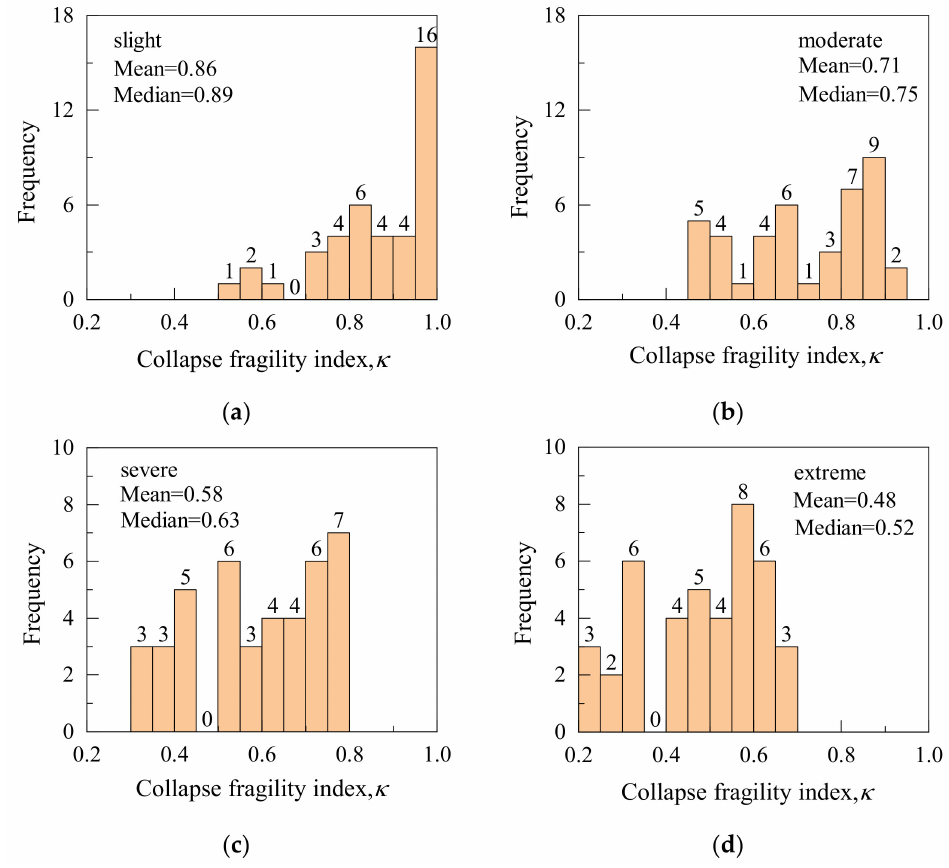
Figure 9. Frequency distribution of collapse fragility index of column specimen under different damage degrees. ( a ) Under the slight damage state. ( b ) Under the moderate damage state. ( c ) Under the severe damage state. ( d ) Under the extreme damage